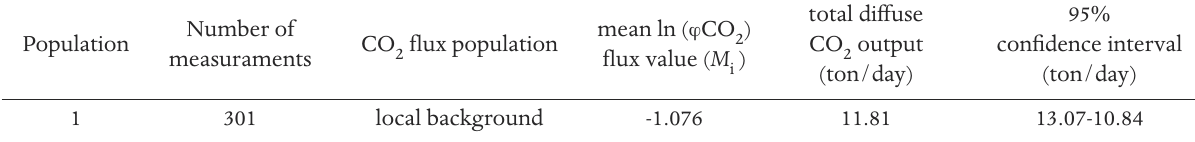
output calculated according to Sinclair [1974] and Sichel’s 2